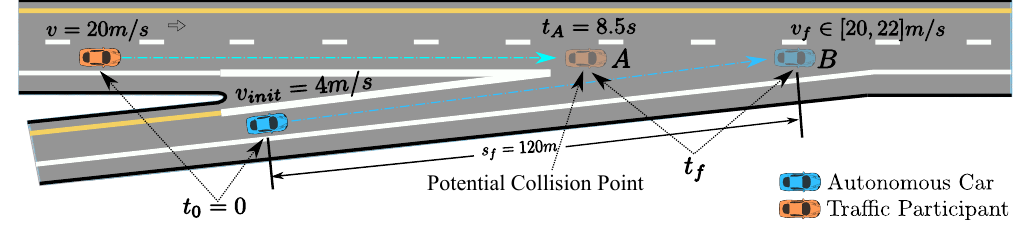
Figure 21. Freeway entrance ramp merging scenario.